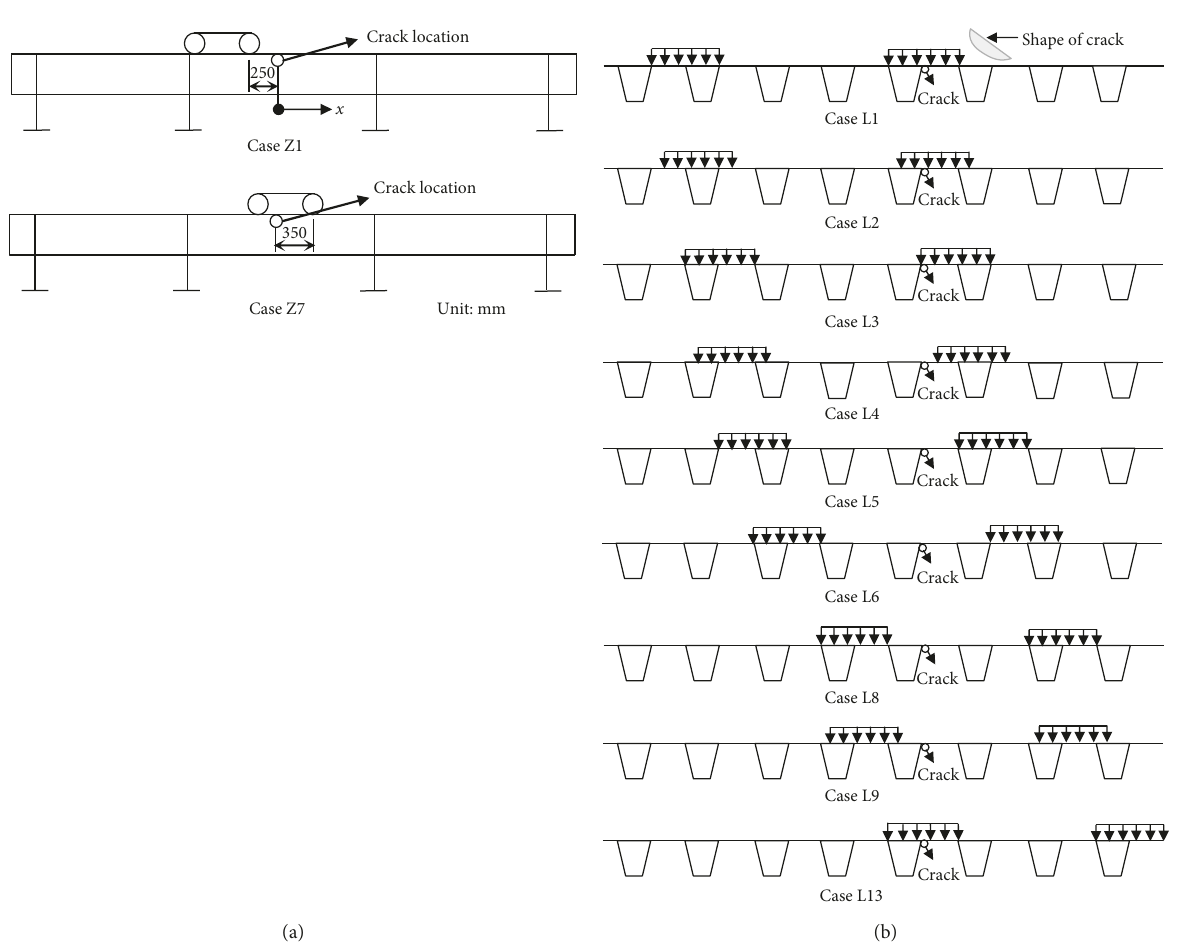
Figure 7: Loading cases. (a) Longitudinal loading cases. (b) Lateral loading cases.